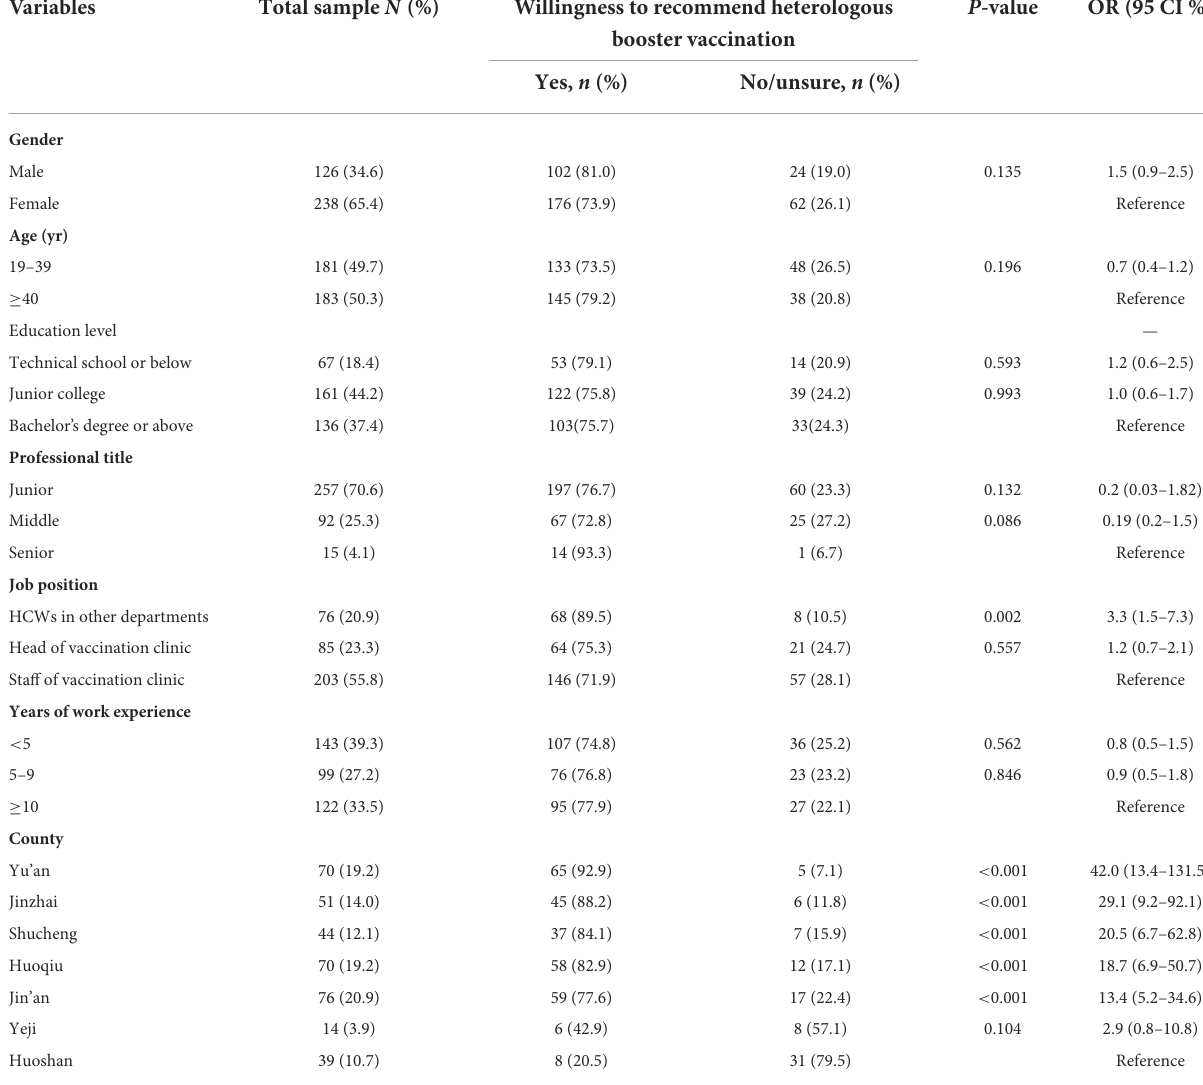
TABLE 1 Characteristics of HCWs and their willingness to recommend the heterologous booster vaccination against COVID-19 ( N =